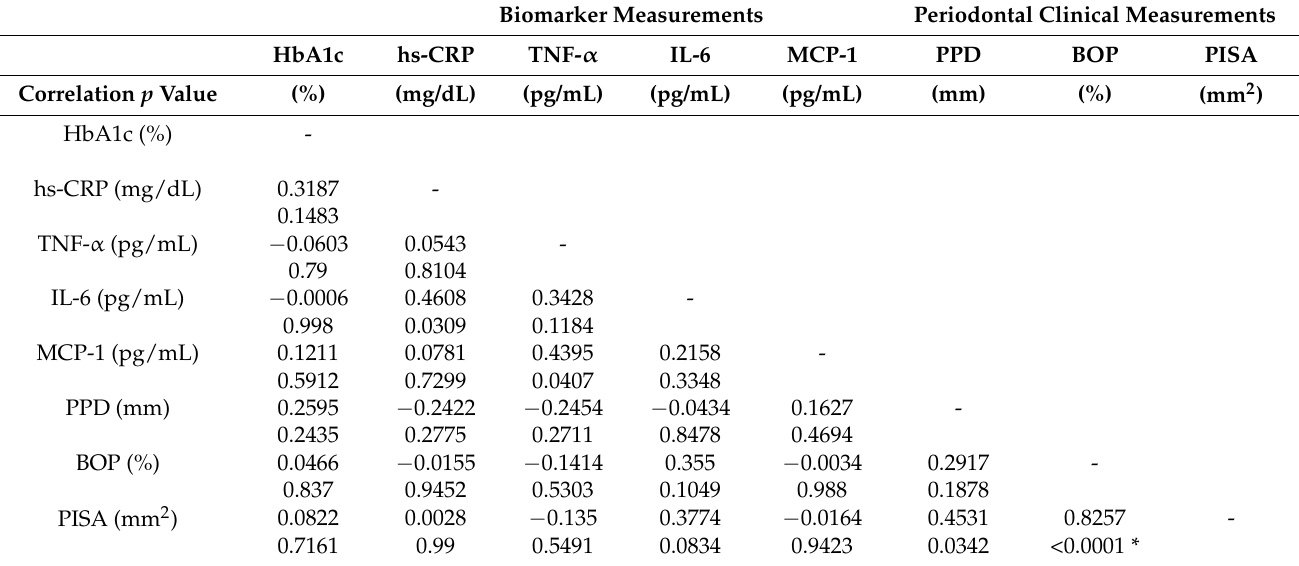
Table 7. Correlations between changes in HbA1c, inflammatory markers, and clinical parameters in the control group over nine